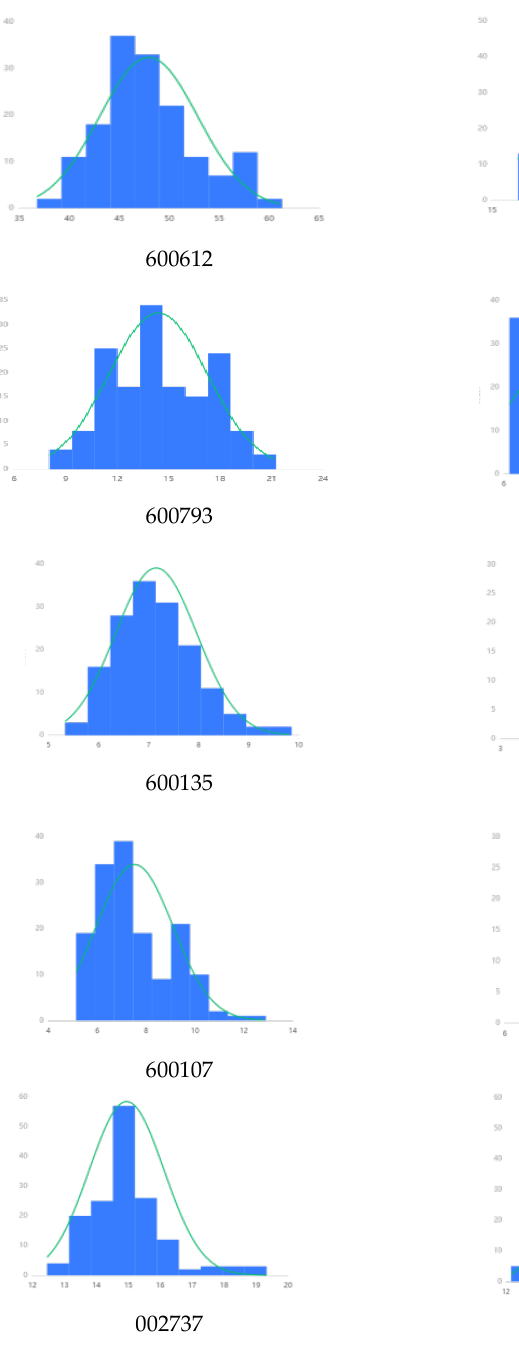
Figure 6. Histogram of normality test.